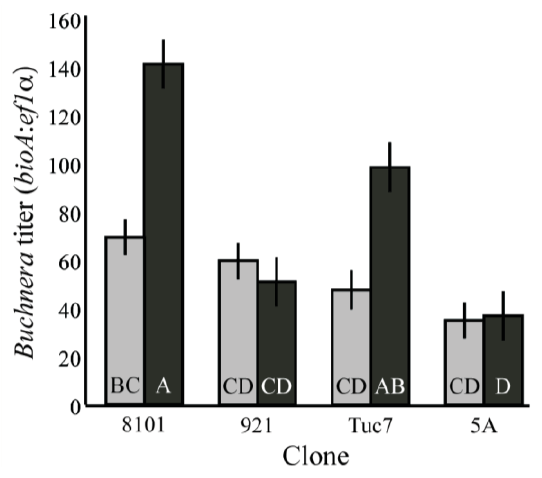
Figure 2. Titer of 4 th instar A. pisum in comparison to 1 st instar aphids from the same clones. Light bars – 1 st instar aphids; dark bars 4 th instar aphids. There was a significant difference in titer between 1 st and 4 th instar clones (F Bars with different letters are significantly different (p < 0.05, Tukey’s HSD). Error bars are ±